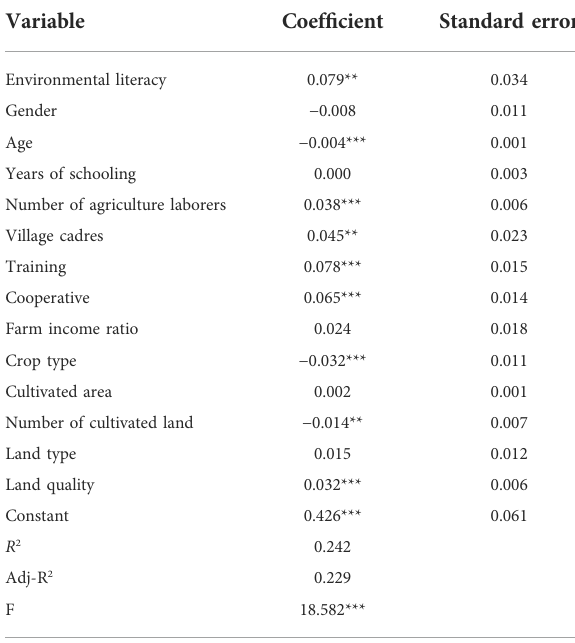
TABLE 5Regression results of theimpactofenvironmentalliteracy on farmers ’ AGP behavior.